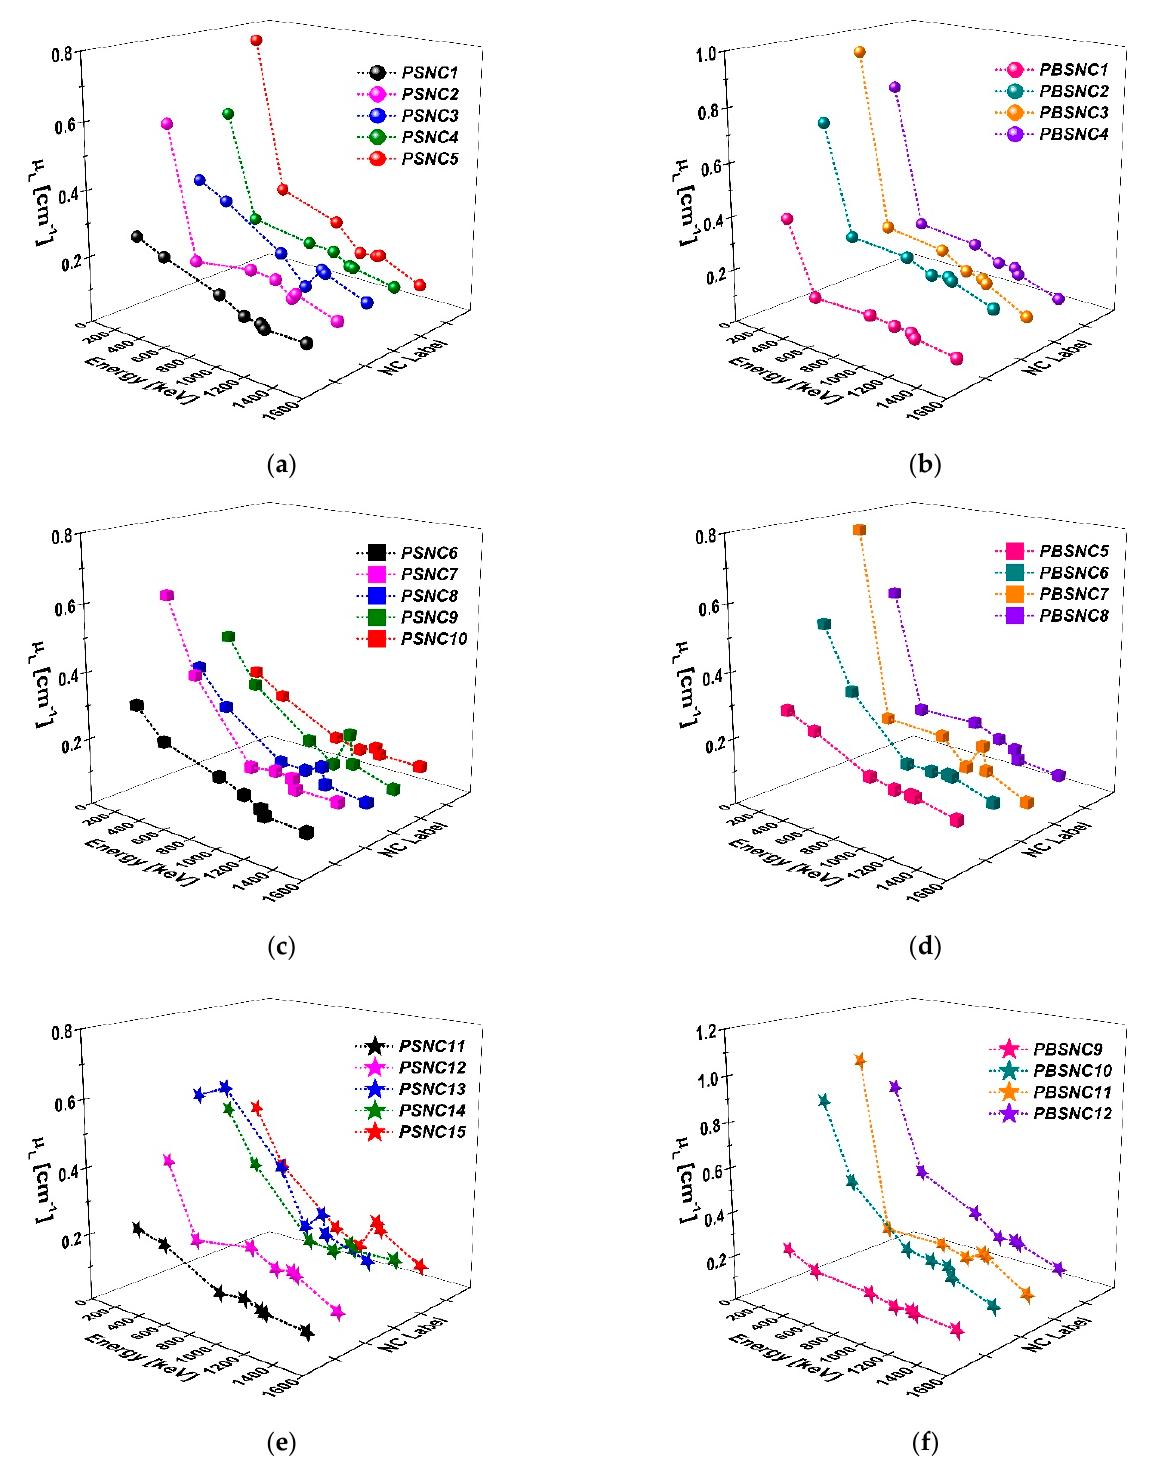
Figure 7. The µ L rates of the PS-b-PEG copolymers blended with the nanostructured SeO 2 and BN particles under a wide range of gamma irradiation energies: PSNC1, PSNC2, PSNC3, PSNC4, and PSNC5 ( a ); PBSNC1, PBSNC2, PBSNC3, and PBSNC4 ( b ); PSNC6, PSNC7, PSNC8, PSNC9, and PSNC10 ( c ); PBSNC5, PBSNC6, PBSNC7, and PBSNC8 ( d ); PSNC11, PSNC12, PSNC13, PSNC14, and PSNC15 ( e ); PBSNC9, PBSNC10, PBSNC11, and PBSNC12 ( f ). The (cid:2020) (cid:3013) rates tend to decrease as gamma energies increase (as can be seen in Figure 7). It was concluded that the experimental and theoretical (cid:2020) (cid:3013) rates showed good harmony